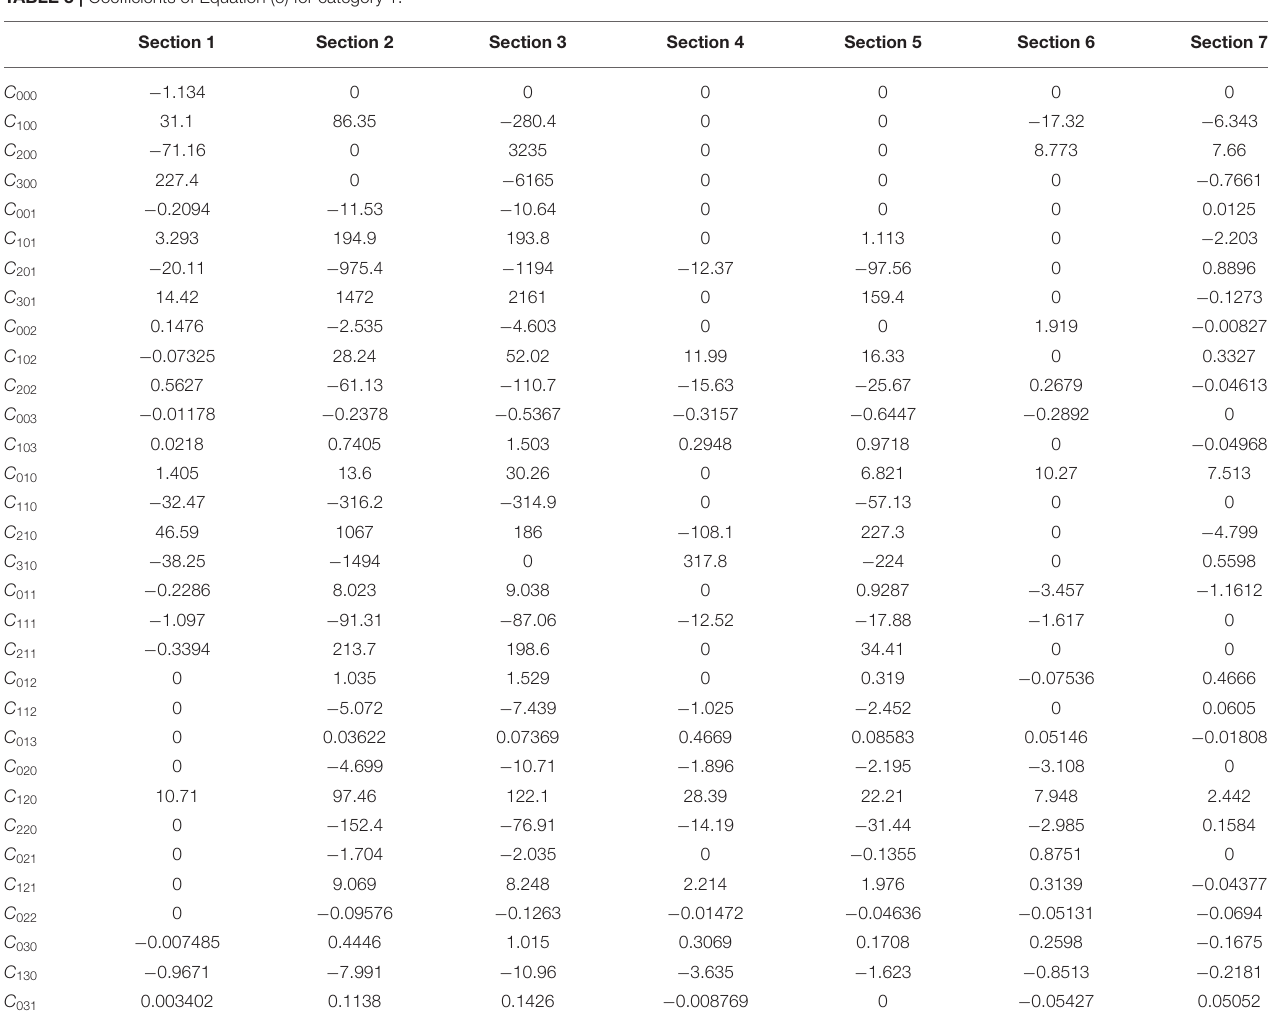
TABLE 3 | Coefficients of Equation (6) for category